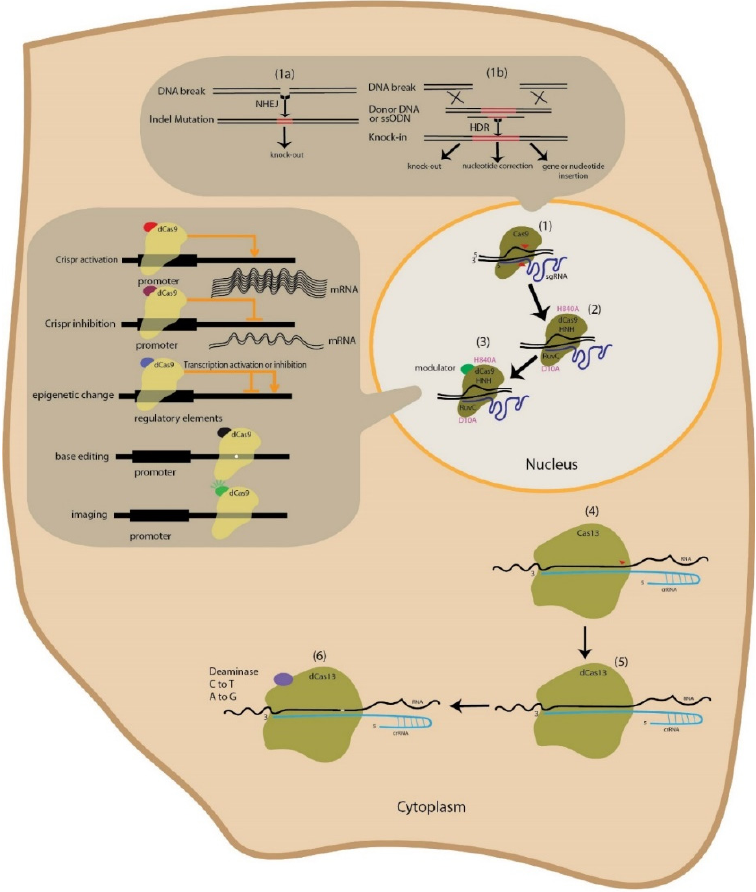
Figure 1. An overview of the CRISPR technology. (1) In the CRISPR system, Cas9 target sites are identified by 20 sgRNA nucleotides that complement the target site. Then, double-strand DNA blunt end cuts are obtained using the Cas9 protein. After DNA is cut within the cell, DNA repair can be accomplished either through NHEJ or HDR. (1a) In NHEJ, the predominant repair system in mammalian cells, a few nucleotides are added to or removed from the cut area (INDEL mutation). This repair system is mainly used for gene knock-out. (1b) The repair system used by cells, the HDR, is performed with high accuracy using complementary arms of the incised area. The scientists have inserted several nucleotides into the cut region by inserting ssODN, which has short arms. Larger arms (from a few hundred bases to several kilobases) are used to insert larger fragments that complement the target position. This method is used for gene knock-out, nucleotide correction, and gene or nucleotide insertion. (2) By creating point mutations in the HNH (H840A) and RuvC (D10A) domains, a deactivated Cas9 is created that is attached only to the target area, incapable of making cuts. (3) Fusion of different modulators including transcription activators and inhibitors, epigenetic modifiers, and base editing affect gene expression or the reporter domains, which, for imaging purposes, can be used to make targeted changes at the transcriptional level and to purposefully label an area of DNA. (4) Additionally, Cas13 can make targeted RNA cleavage (guided by crRNA). (5) By creating a point mutation in the Cas13 protein-coding sequence, Cas13 is deactivated with the ability to bind to RNA without cutting it. (6) By attaching the deaminase domains, the ability to make single-base changes in RNA is